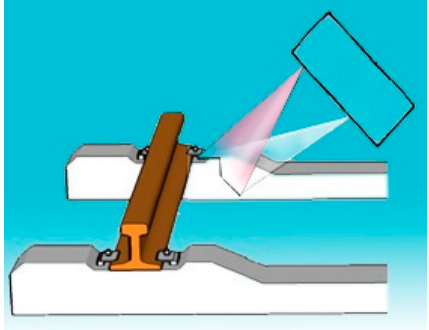
Figure 5. Structured light profilometer [43].